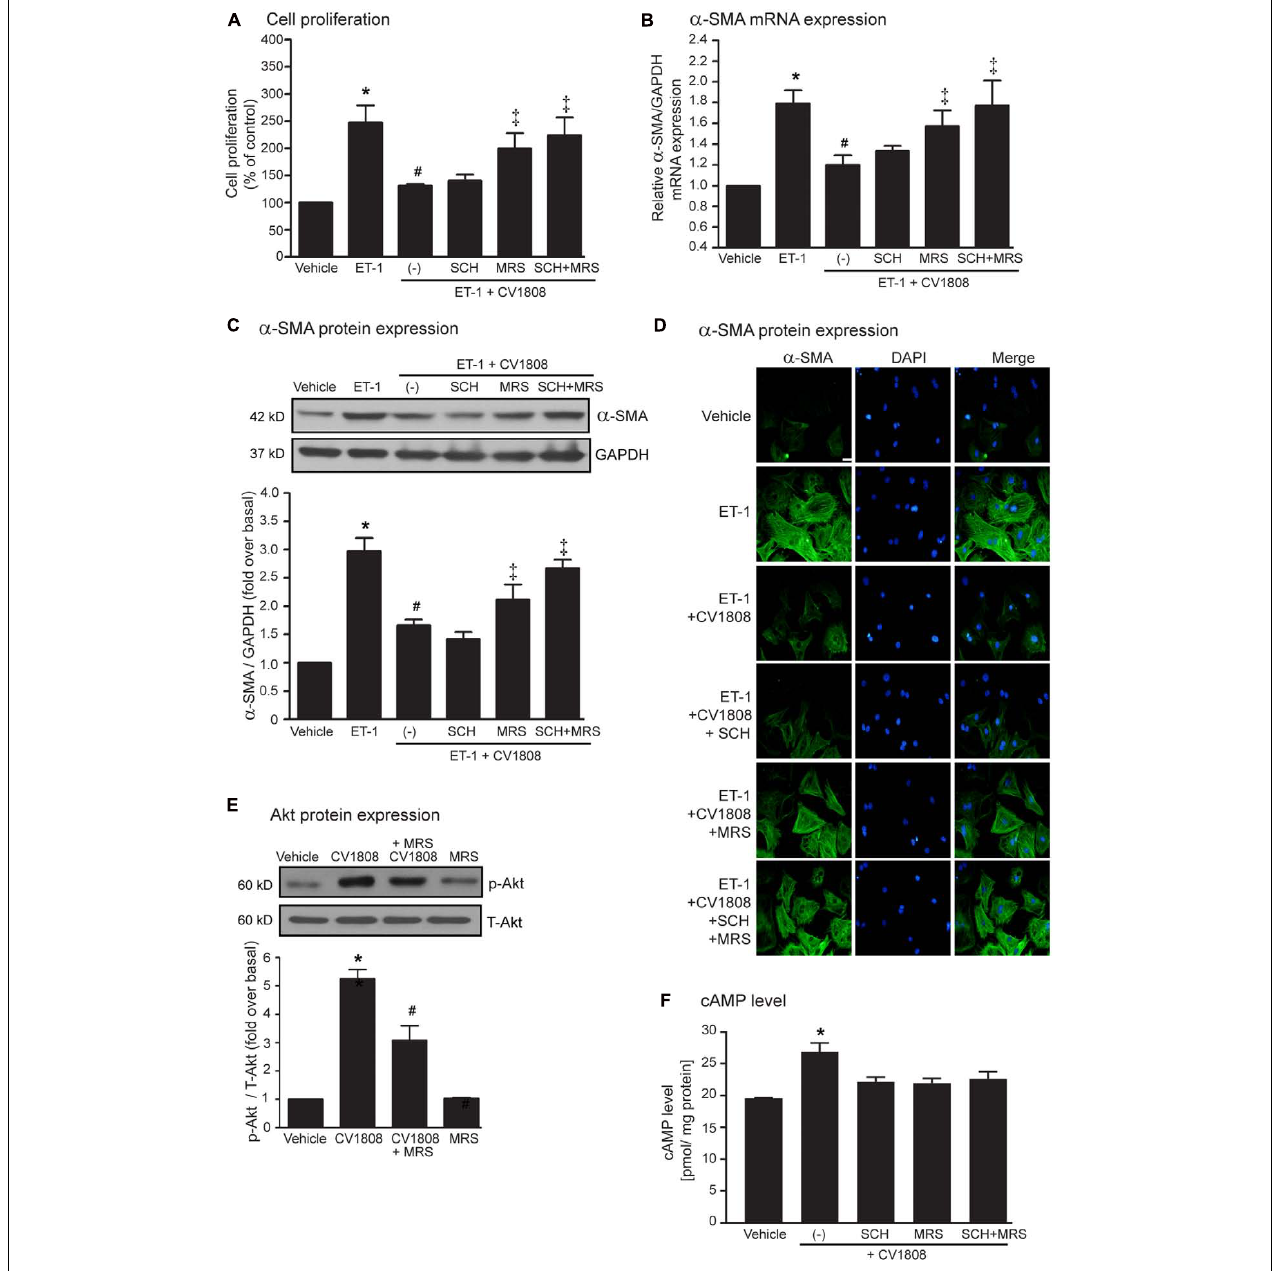
FIGURE 6 | Stimulation of the A 2B receptor inhibits ET-1-induced cell proliferation and α -SMA synthesis. (A–D) Cardiac fibroblasts were pretreated without or with either 0.5 µ M SCH58261 (SCH; A 2A receptor antagonist), 0.5 µ M MRS1754 (MRS; A 2B receptor antagonist), or both for 1 h before treatment with vehicle (control), or 10 µ M CV1808 for 1 h and further stimulated with 20 nM ET-1 for 12 h (B) or 24 h (A,C,D) at 37 ◦ C. (A) Cell proliferation was quantified by MTT assay. The data were expressed as the percentage relative to the non-treated group, and shown as mean ± SEM ( n = 4). ∗ P < 0.05 vs. vehicle; # P < 0.05 vs. ET-1; ‡ P < 0.05 vs. ET-1+CV1808. (B,C) Relative α -SMA mRNA (B) and protein (C) levels were quantified and shown as the mean ± SEM ( n = 4). ∗ P < 0.05 vs. vehicle; # P < 0.05 vs. ET-1; ‡ P < 0.05 vs. ET-1+CV1808. (D) Cells were incubated with anti- α -SMA antibody followed by goat anti-mouse antibody (Alexa Fluor 488). The α -SMA was visualized by fluorescent microscope. Cells were stained for α -SMA (green) and nuclear staining of nucleus with DAPI (blue). Bar, 10 µ m. (E) Cells were pretreated without or with 0.5 µ M MRS1754 for 1 h. After 1 h, cells were treated with vehicle (DMSO), or 10 µ M CV1808 for 30 min. Cell lysates were immunoblotted with anti-phospho-Akt and anti-Akt antibodies. The Akt activation was quantified, expressed as fold increase over vehicle, and shown as the mean ± SEM ( n = 3). ∗ P < 0.05 vs. vehicle; # P < 0.05 vs. CV1808. (F) Cardiac fibroblasts were pretreated with 1 µ M SCH, 1 µ M MRS, or SCH plus MRS for 1 h before stimulation with 10 µ M CV1808 for 30 min. The cAMP levels were measured using cyclic AMP ELISA kit and shown as [pmol/ mg protein] ( n = 4). ∗ P < 0.05 vs. vehicle.